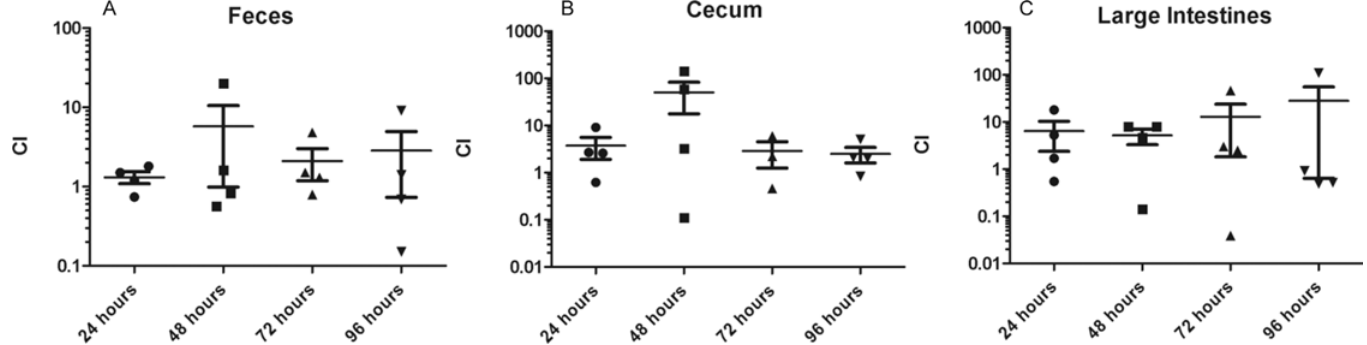
Fig 6. Competitive index in vivo of wild type O104:H4 and Δ lpfA1 strains. Six to eight week old CD-1 ICR mice where infected with 1x10 9 O104:H4 2011 c3494 wild type (n = 12) and Δ lpfA1 (n = 12) totaling 2x10 9 CFU. Collections were done at 24 (solid circles), 48 (solid squares), 72 (solid triangles), and 96 h (inverted triangles). Fecal shedding (A), ceca (B), and large intestine (C) recoveries of both strains are expressed as Competitive Index (CI = % Δ lpfA1 recovered / % wild type recovered). Error bars indicated SEM of 4